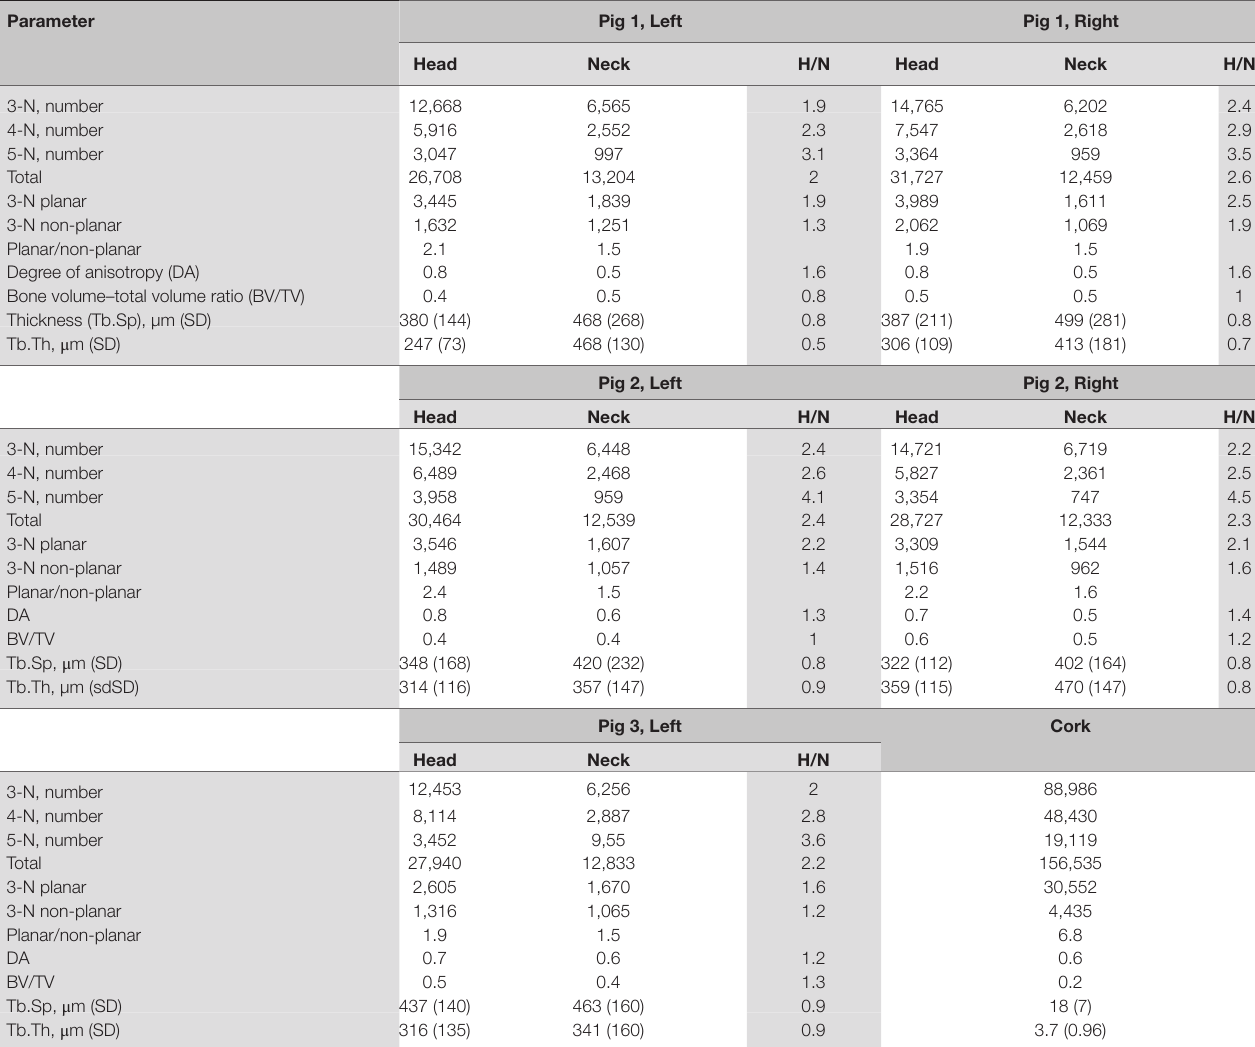
TaBle 3 | Morphometric and topological parameters in the trabecular network of the pig mandible, condylar head (H), and neck (N), and their ratio. Parameter Pig 1, left Pig 1, right head neck h/n head neck h/n 3-N,